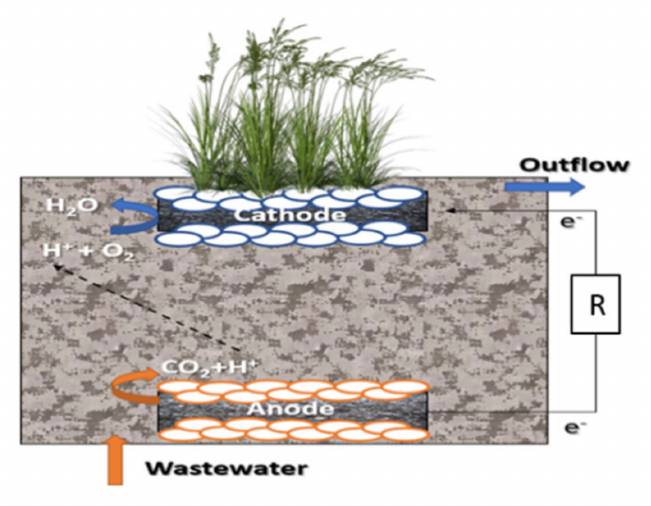
Figure 1. Schematic of constructed wetland MFC (CW-MFC) setup (R: Resistance). Aquatic plants transport oxygen required for aerobic respiration to the root